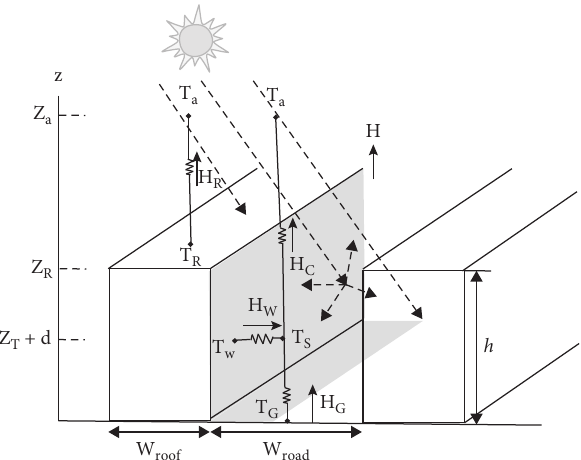
Figure 2: Diagram of the single-layer urban canopy model (SLUCM): Z T is the roughness length for heat, Z R (h) is the mean building height, Z a is the bottom layer height of the parent NWP model, T R , T W , and T G are roof, wall, and ground temperature, T a is the air temperature at Z a , T S is the temperature defined at height Z T + d , H R represents the sensible heat flux from roof to the atmosphere, H W and H G are sensible heat flux from wall and ground to the urban canyon space, H is the weight-mean sensible heat flux at Z a , and W roof and W road are the width of roof and